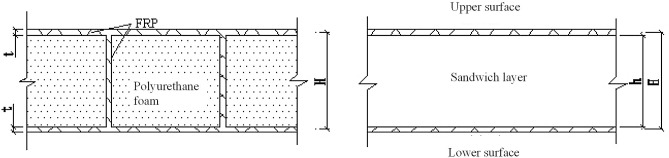
Schematic diagram of an original sandwich panel and the corresponding simulated sandwich panel.